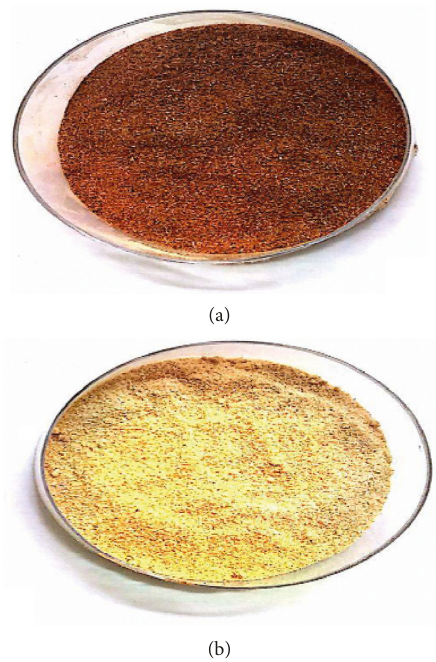
Figure 1: Visual aspect of the two filter materials: (a) red wood sawdust (SBR); (b) catia wood sawdust